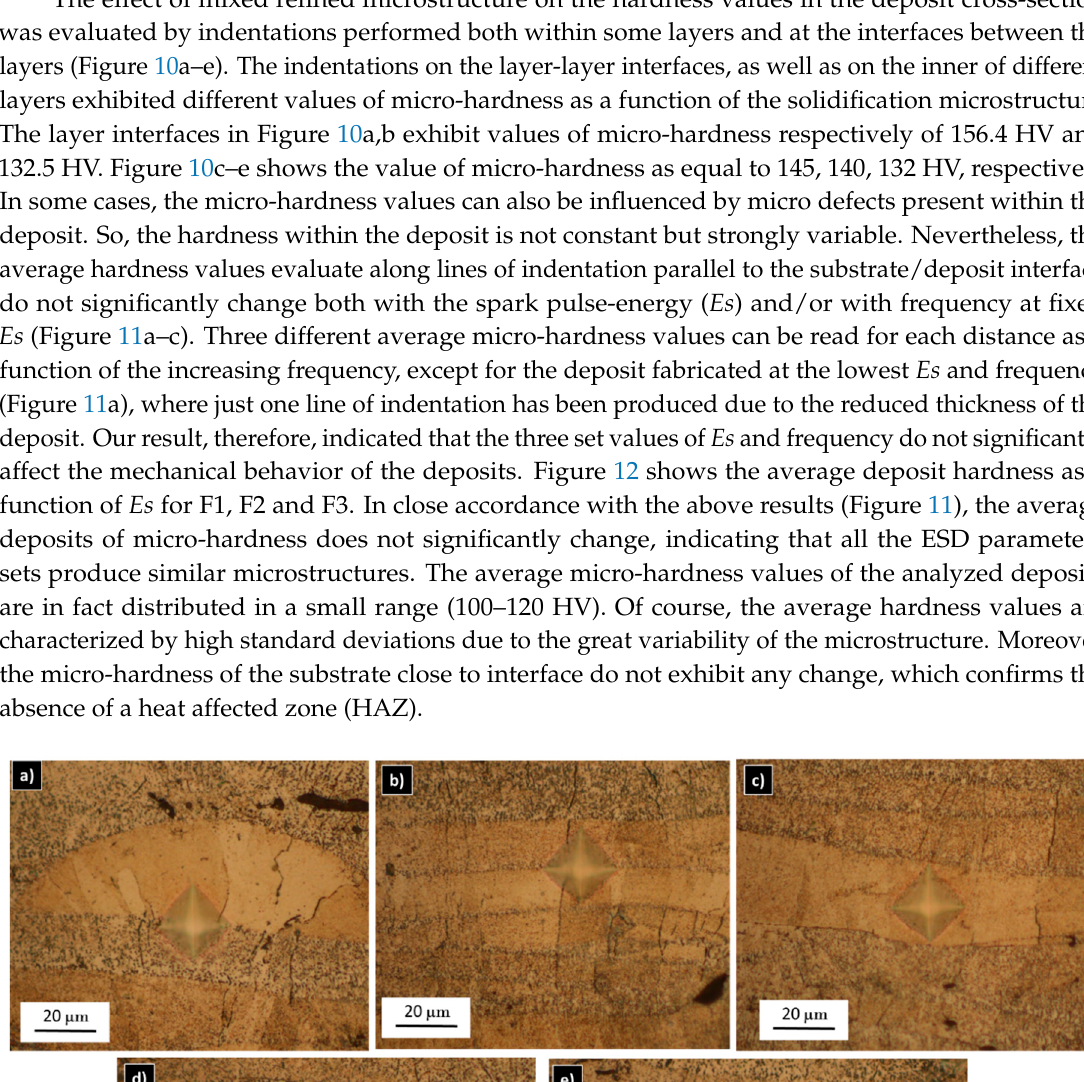
Figure 11. Micro-hardness as a function of the distance from substrate/deposit interface for the different parameters adopted: ( a ) V1, C2, 10 L/min ( Es = 0.5 J), ( b ) V2, C1, 10 L/min ( Es = 0.9 J) and ( c ) V2, C2, 10 L/min ( Es = 1.125 J).